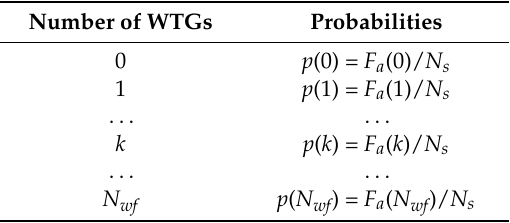
Table 2. Discrete probability distribution of grid-connected wind turbine generators